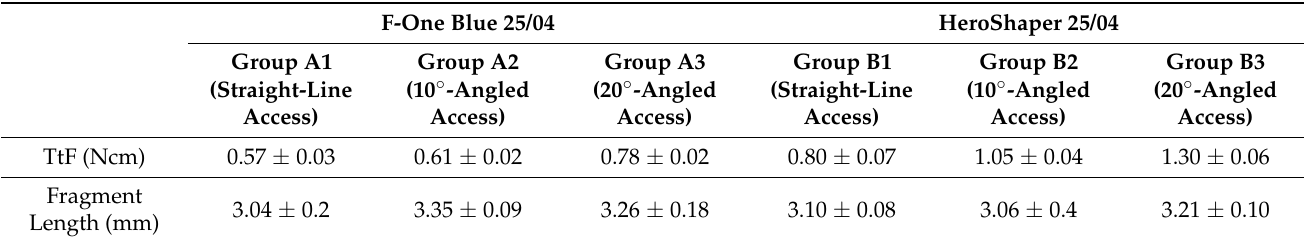
Table 1. Summary of the results of TtF and FL with mean values and standard deviations according to the different endodontic rotary instrument